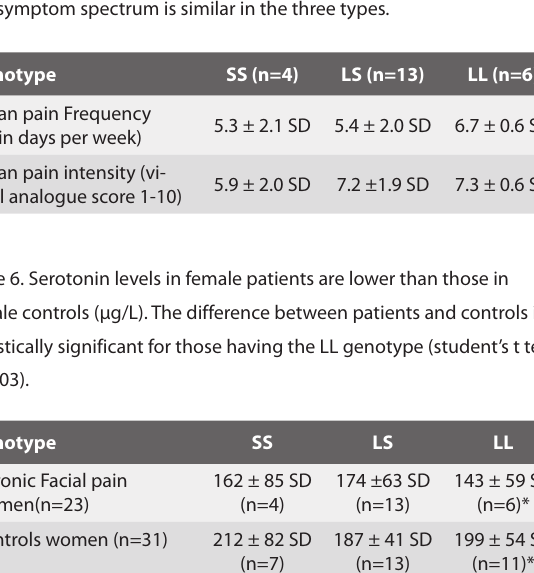
Table 5. Clinical symptoms in 23 patients with the different genotypes. The symptom spectrum is similar in the three types.